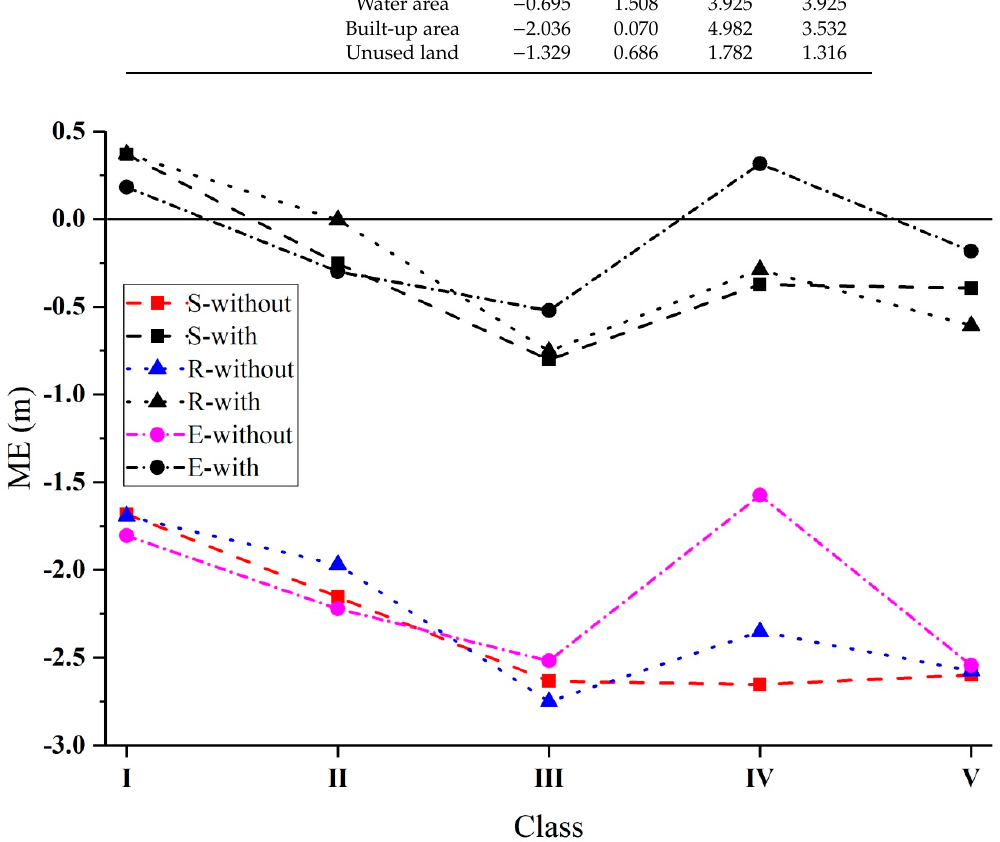
Figure 8. Influence of terrain slope, relief and elevation classes on the MEs of SRTM3 DEM without and with data coregistration (I: (0–5°) for slope class, (0–100 m) for relief and elevation classes; II: (5–10°) for slope class, (100–200 m) for relief and elevation classes; III: (10–15°) for slope class, (200–300 m) for relief and elevation classes; IV: (15–20°) for slope class, (300–400 m) for relief and elevation classes; V: (>20°) for slope class, (>400 m) for relief and elevation classes. “S”, “R” and “E” stand for slope, relief, and elevation, respectively.).